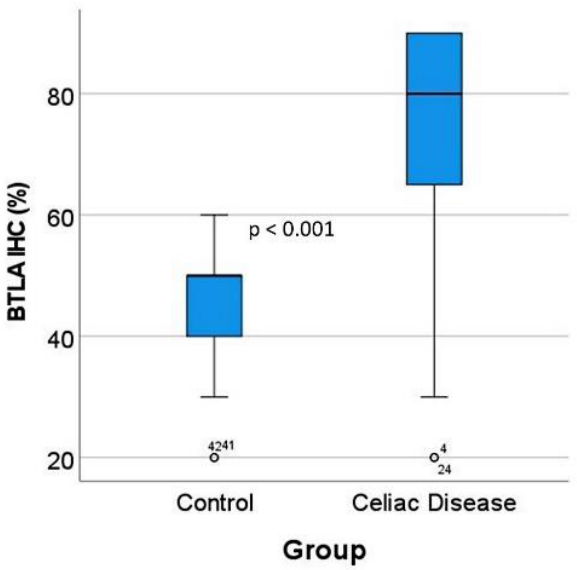
Figure 7. BTLA protein expression by immunohistochemistry in the validation series. After BTLA immunohistochemistry and quantification, celiac disease cases were characterized by high BTLA protein expression ( p < 0.001). The outliers are marked with a circle, next to the icon there is a number that corresponds to the case